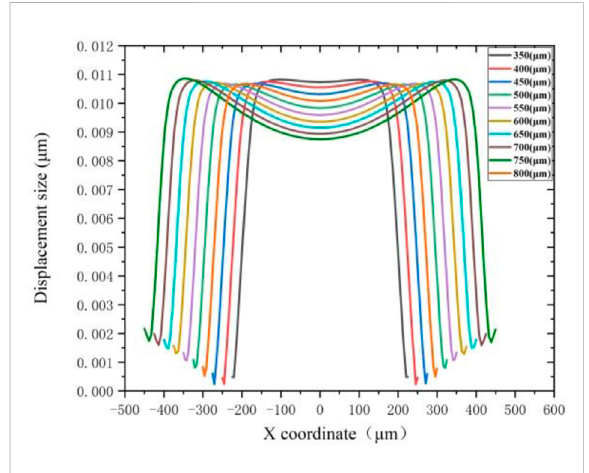
FIGURE 6 Displacement of semiconductor membranes at different d1.